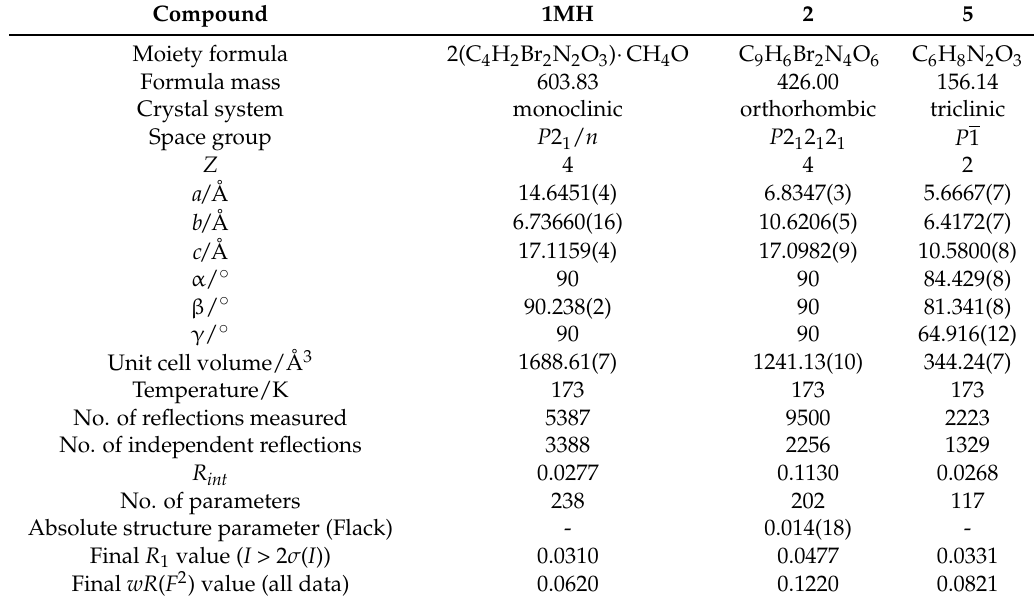
Table 1. Crystallographic details for 1MH , 2 and 5 .